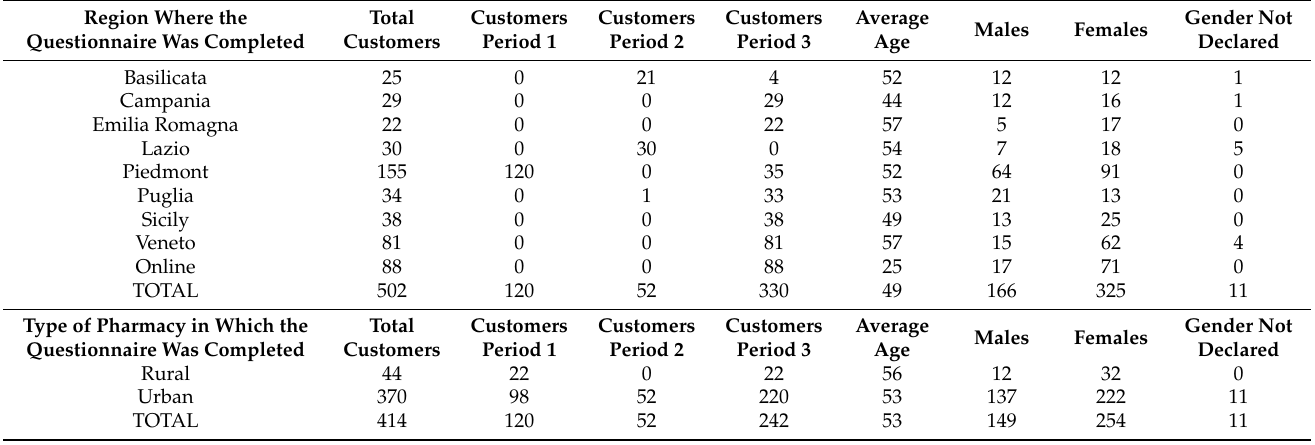
Table 2. Number of customers participating in data collection divided by region, period, age, gender, type of pharmacy. Region Where the Questionnaire Was